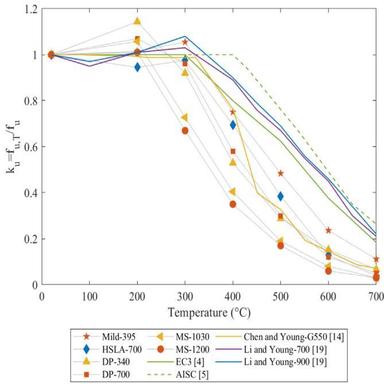
Comparison of ultimate stress obtained from steady-state tests.